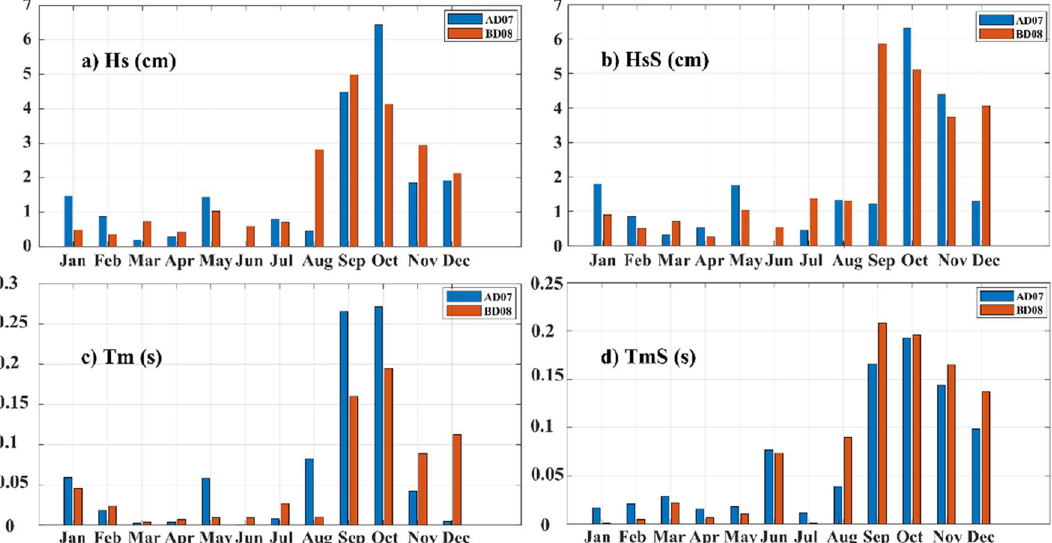
Figure 2. Monthly averaged difference of W3 no_ice and W3 with_ice for ( a ) significant wave height, Hs, ( b ) the swell wave height, HsS, ( c ) the mean wave period, Tm, and ( d ) the swell period, TmS at the AD07 (blue bars) and BD08 (red bars) mooring